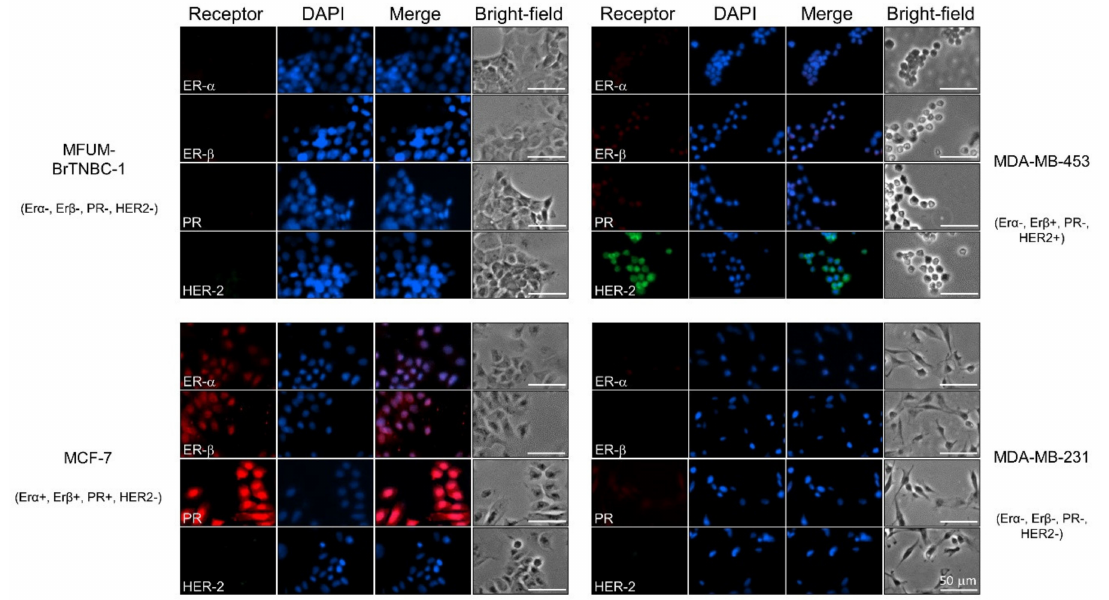
Figure 3. Comparative characterisation of receptor status for human breast cancer cell lines MFUM- BrTNBC-1, MCF-7, MDA-MB-453 and MDA-MB-231. Legend: Immunofluorescence staining was carried out in triplicate for all CLs, and representative images are shown. ER- α —oestrogen α receptor, ER- β —oestrogen β receptor, PR—progesterone receptor, HER-2—human epidermal growth factor receptor 2. Scale bar = 50